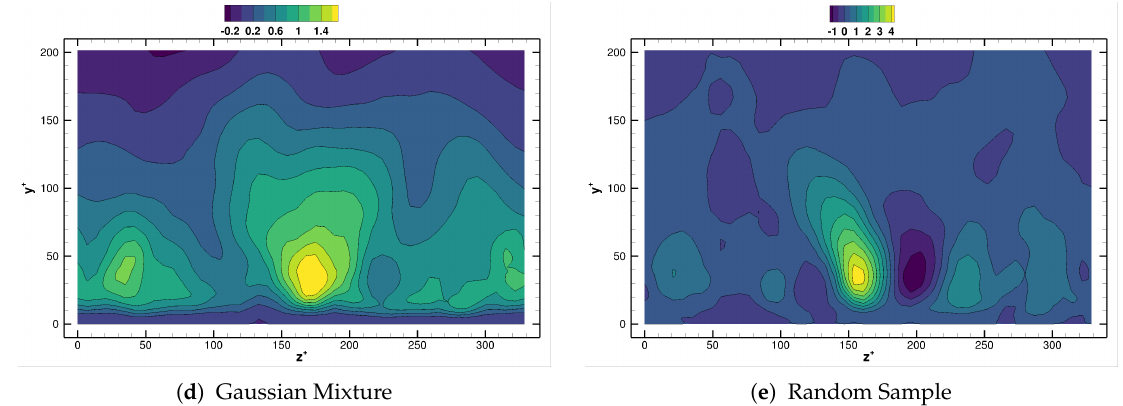
(cid:48) v (cid:48) (cid:105) ( y + , z + ) using u 2 τ